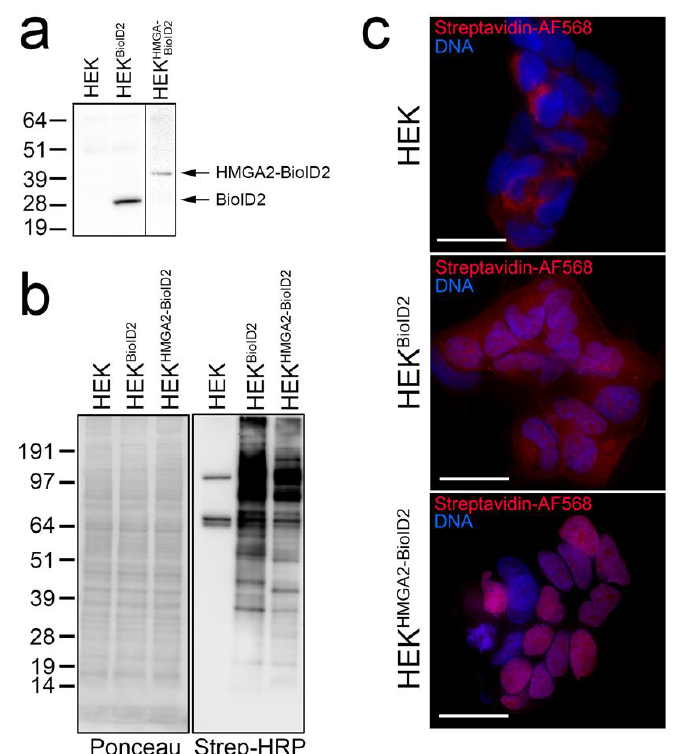
Figure 1. ( a – c ) Validation of BioID2 stable cell lines for BioID. ( a ) Western blot analysis of the apparent MW of myc-tagged BioID2 and Flag-BioID2-tagged HMGA2 stably expressed in HEK cells and detected using anti-myc (Millipore Sigma, Burlington MA, USA) or anti-Flag (Millipore Sigma, Burlington MA, USA) antibodies, respectively. ( b ) Western blot analysis of whole cell lysates (50 µ g total protein loaded) harvested from the HEK parental cell line and HEK-BioID2 and HEK-HMGA2- BioID2 stable cell lines after 4 h labeling with 50 µ M biotin. Ponceau S staining of the membrane after transfer is shown on the left, and Streptavidin-HRP (Thermo-Fisher, Waltham, MA, USA)